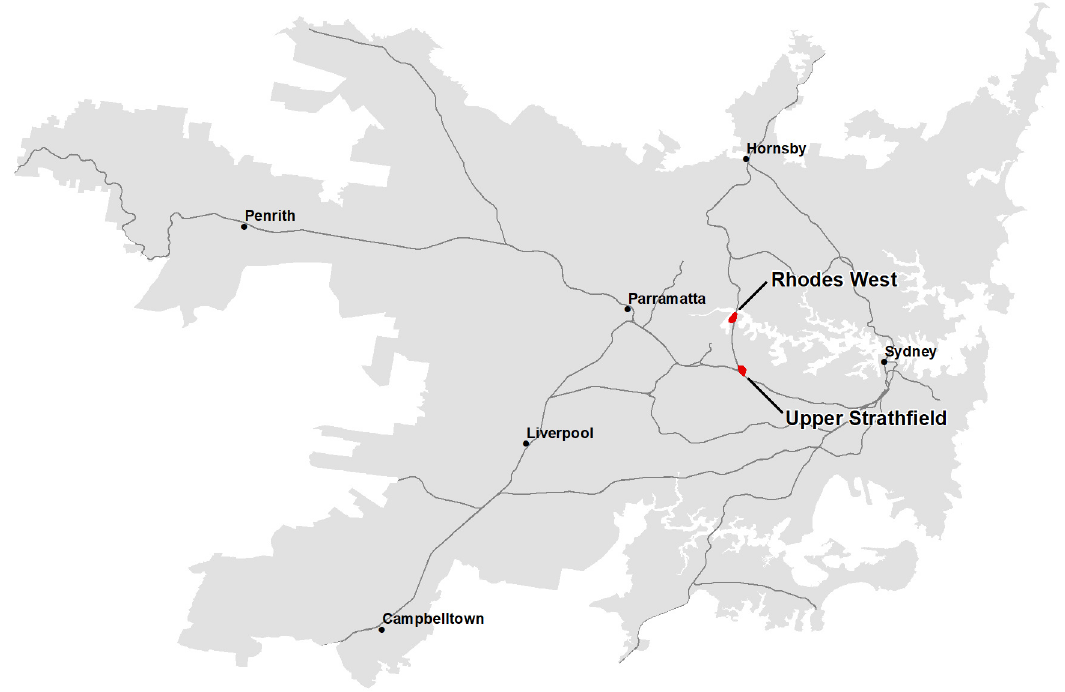
Figure 1. Case study